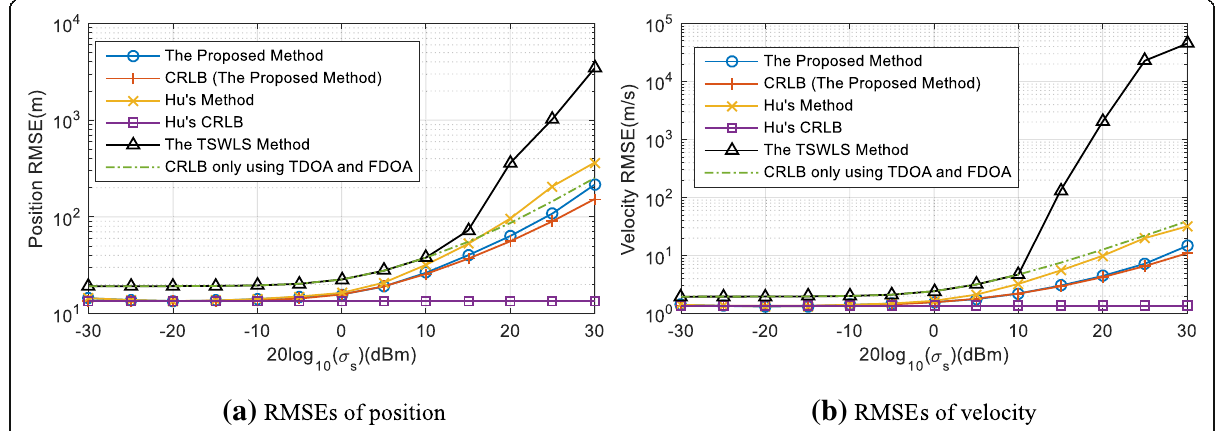
Fig. 5 RMSEs comparison versus receiver location error when SNR = 10 dB. a RMSEs of position. b RMSEs of